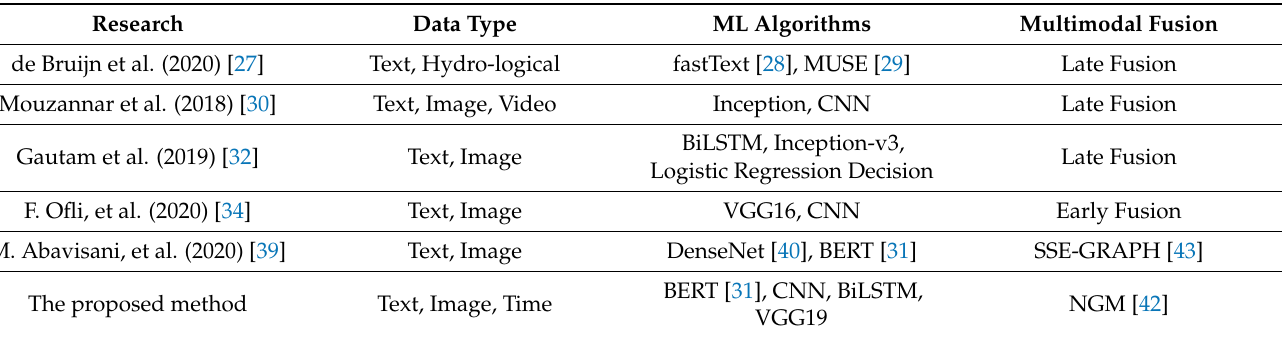
Table 1. Summary of related works in multimodal